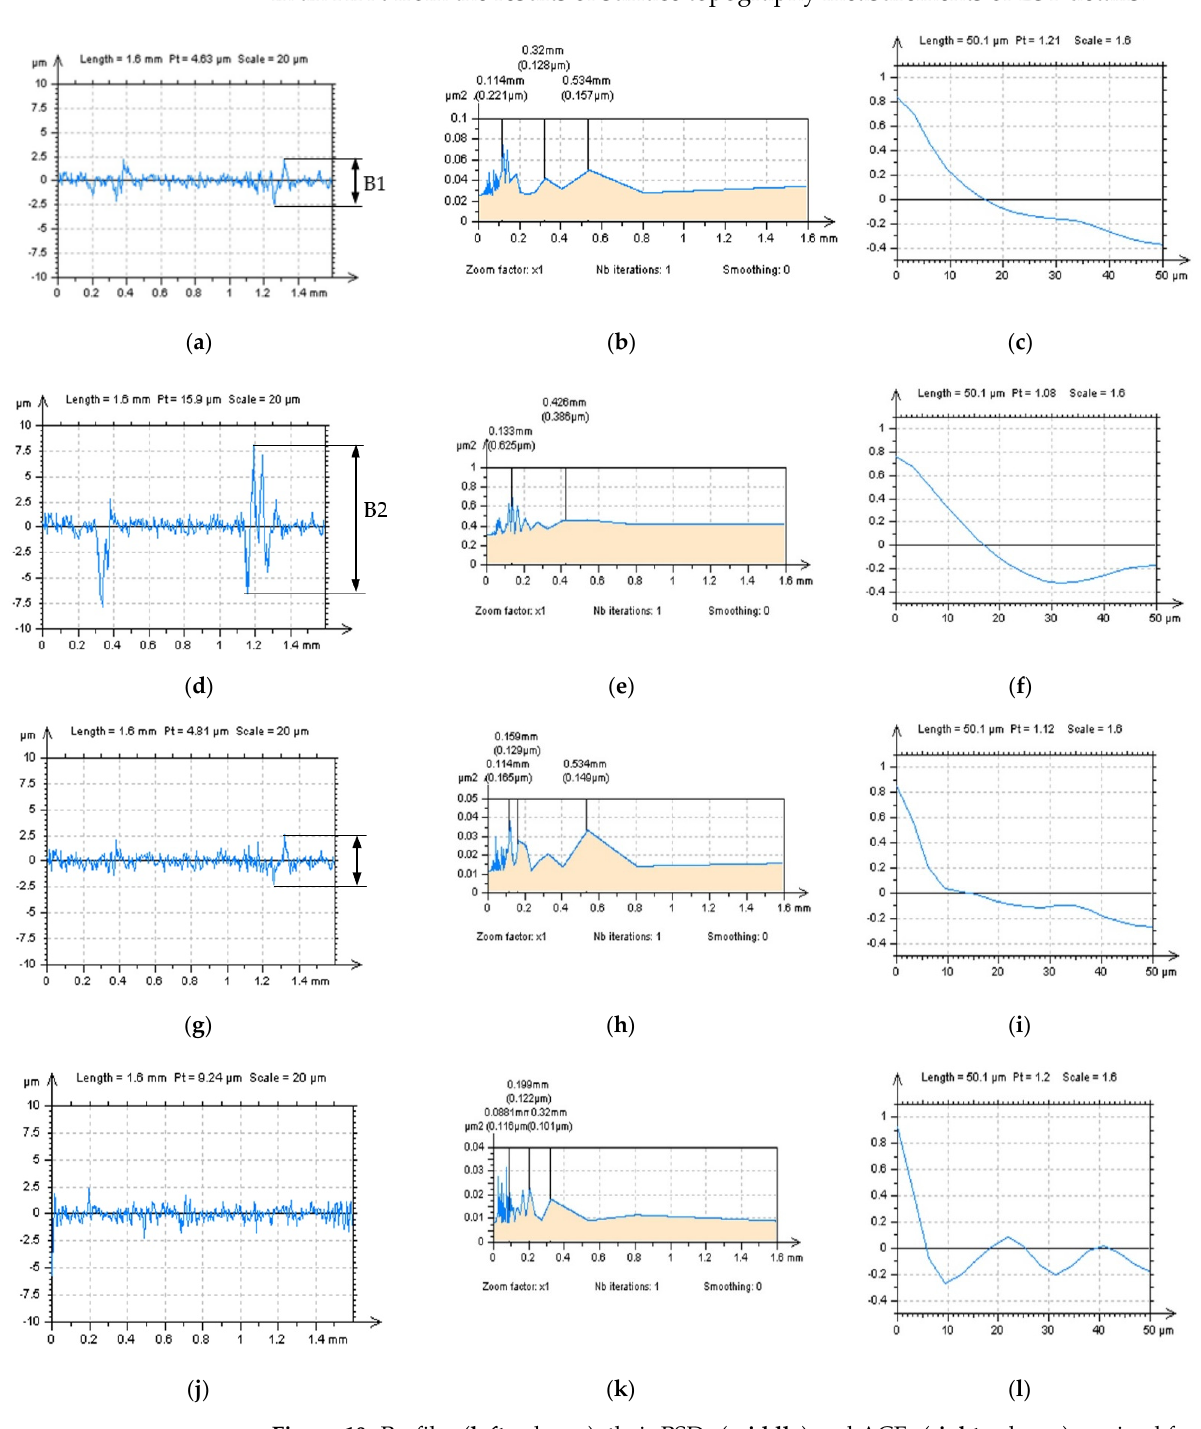
Figure 10. Profiles ( left column), their PSDs ( middle ) and ACFs ( right column) received from the NS created from 60° LST by application of GF ( a – c ), RGF ( d – f ), SF ( g – i ) and FFTF ( j – l ) method, cutoff = 0.025 mm.